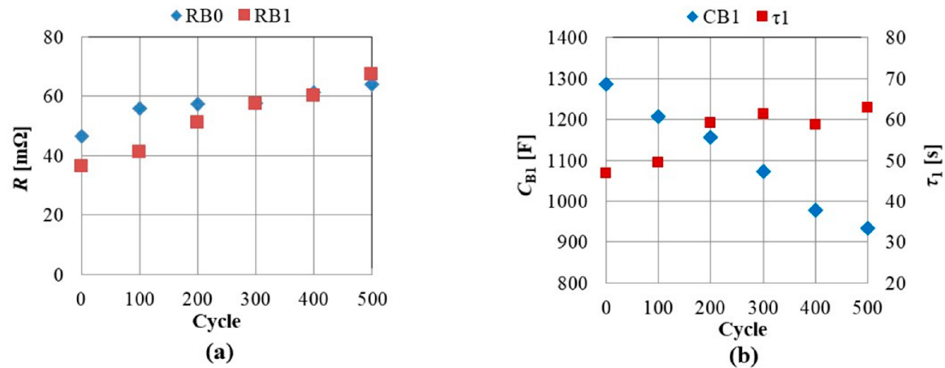
Figure 6. Deterioration dependence of equivalent circuit parameters. ( a ) R B0 and R B1 . ( b ) C B1 and τ 1 .